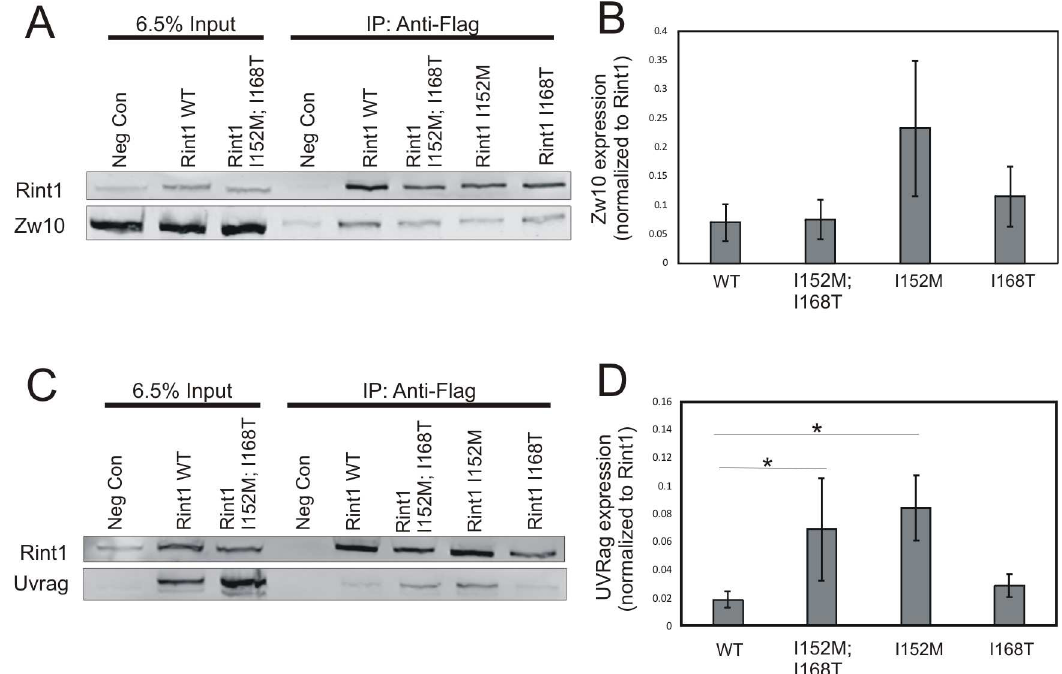
Fig 4. In vitro characterization of missense variants in RINT1 . FLAG-tagged RINT1 mutant plasmidswere transfected into HEK293Tcells and an anti-FLAG antibodywas then usedto immunoprecipitateRINT1 and interacting proteinsfrom cell lysate. Cellstransfectedwith empty vector served as the negativecontrol (Neg Con). Cells transfectedwith the RINT1 wildtype(WT) expression vector served as the positivecontrol. A representative immunoblot for ZW10 immunoprecipitation is shown (A). Quantification of the ZW10 immunoprecipitationblots (N = 5) are shown(B). A representative immunoblotfor UVRAG immunoprecipitationis shown(C). Quantification of the UVRAG immunoprecipitationblots (N = 4) are shown(B). The asterisk indicates differenceswith a p (cid:20)